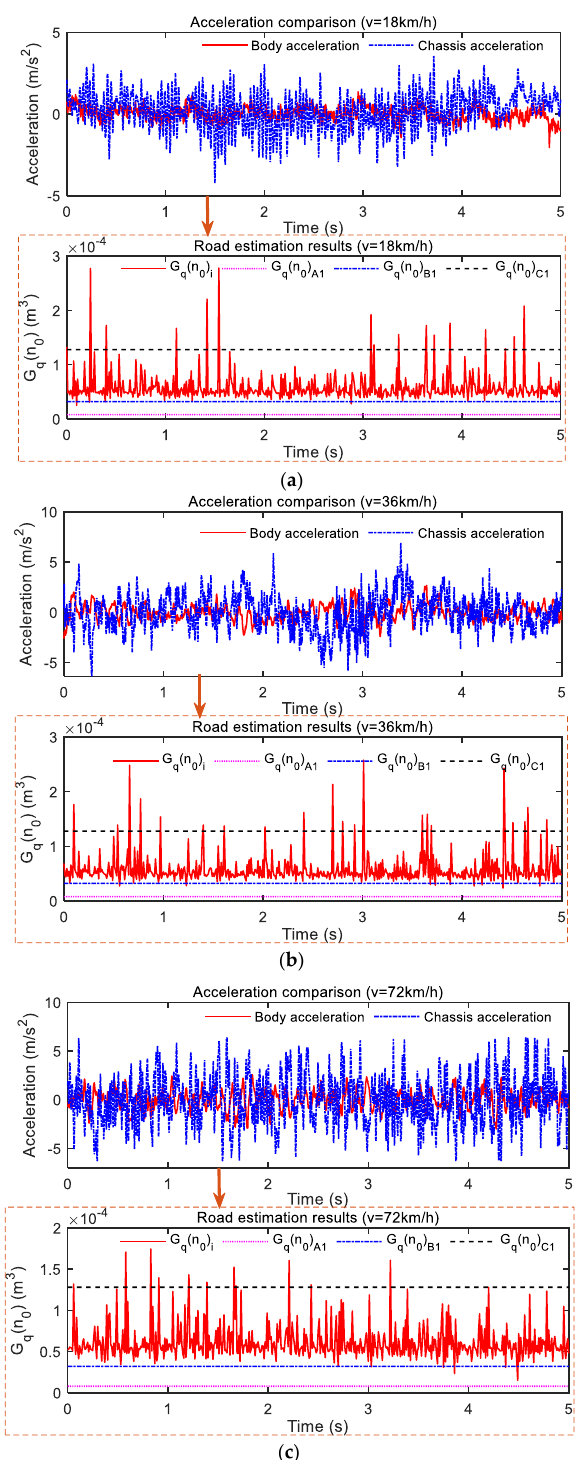
Figure 13. Comparison of road surface estimation at three speeds in road section 2. ( a ) Comparison of results when v = 18 km/h. ( b ) Comparison of results when v = 36 km/h. ( c ) Comparison of results when v = 72 km/h.